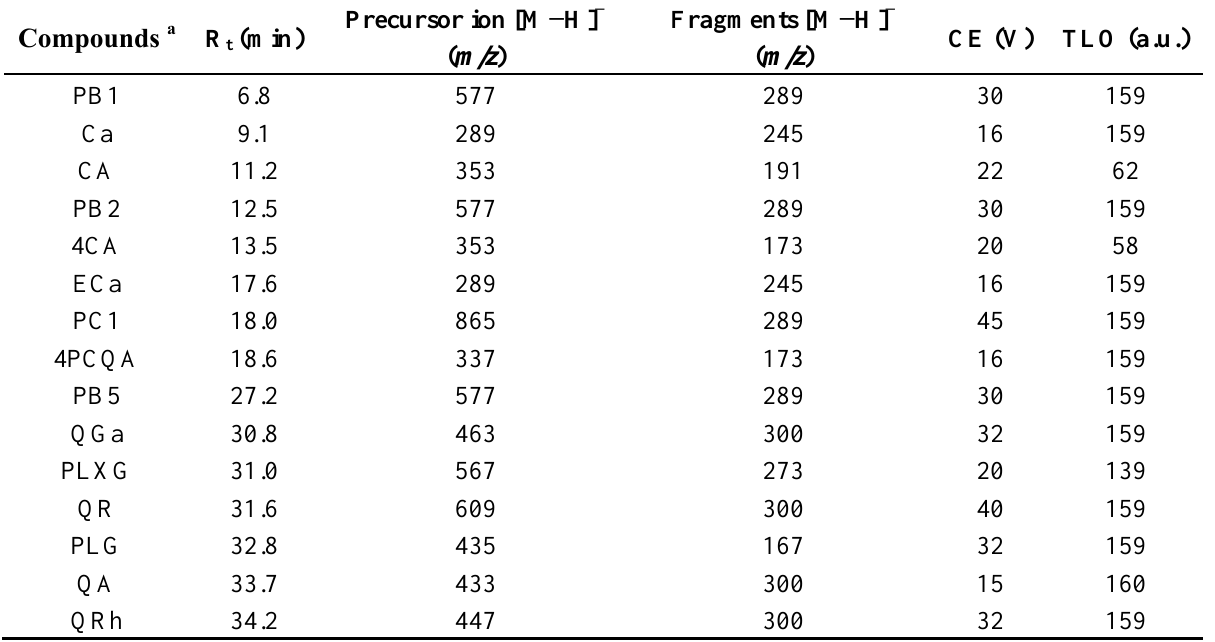
Table 4. Retention time (Rt), MS/MS fragment ions, collision energy (CE) and Tube Lens Offset (TLO) for the 15 major phenolic compounds of apple juices. Compounds